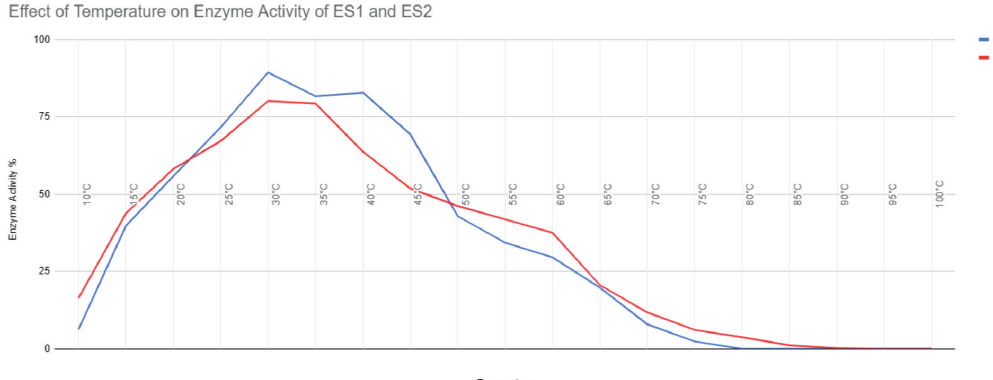
Fig. 1. Effect of temperature on enzyme activity of ES1 and ES2